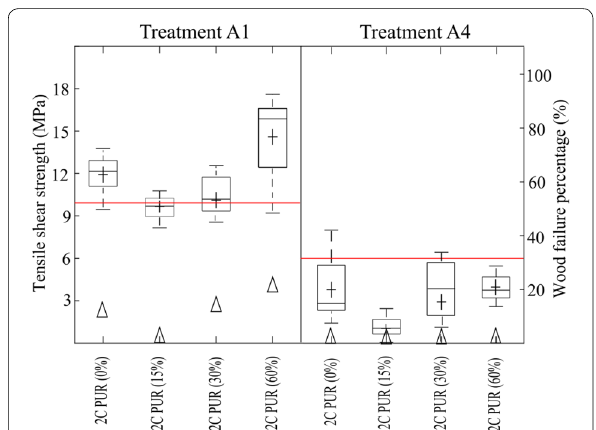
Fig. 4 Boxplots of tensile shear strength (mean value marked as cross) and wood failure (triangle) after treatment A1 and A4 for 2C PUR with different amounts of filler in the resin component (0, 15, 30, 60%). Boxplots indicate median, interquartile range and minimum and maximum are shown as whiskers. Red line marks standards requirement for each treatment according to EN 302-1